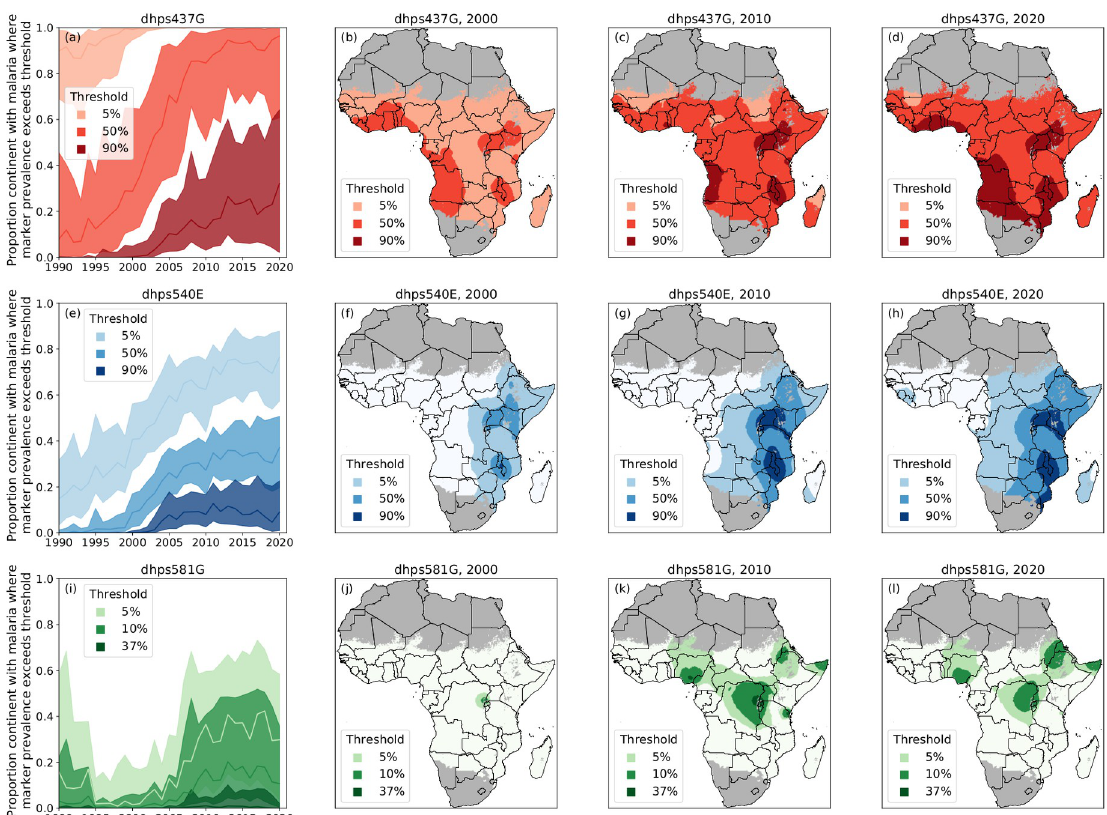
Fig 5. Predicted proportion of Africa that exceeds specific prevalence thresholds. The proportion of the continent within the Pf spatial limits of Africa with pfdhps 437G (a), pfdhps 540E (e) and pfdhps 581G (i) prevalence exceeding relevant thresholds over the time period of 1990 to 2020. The median estimates are shown in the solid-colored lines and the associated uncertainty (50% credible intervals) in the shaded regions. The predicted area with prevalence exceeding relevant thresholds shown in three shades, based on median predictions, for pfdhps 437G (red), pfdhps 540E (blue) and pfdhps 581G (green) in 2000 ((b), (f), (j)), in 2010 ((c), (g), (k)), and 2020 ((d), (h), (l)). The predictive proportions displayed for pfdhps 437G (red) and pfdhps 540E (blue) are 90%, 50% and 5%. For pfdhps 581G (green), present in lower prevalence, the proportions displayed are 37%, 10% and 5%. National shapefiles were obtained from the Malaria Atlas Project (MAP; https://malariaatlas.org/) under their open access policy (https://malariaatlas.org/open-access-policy/) and no changes were